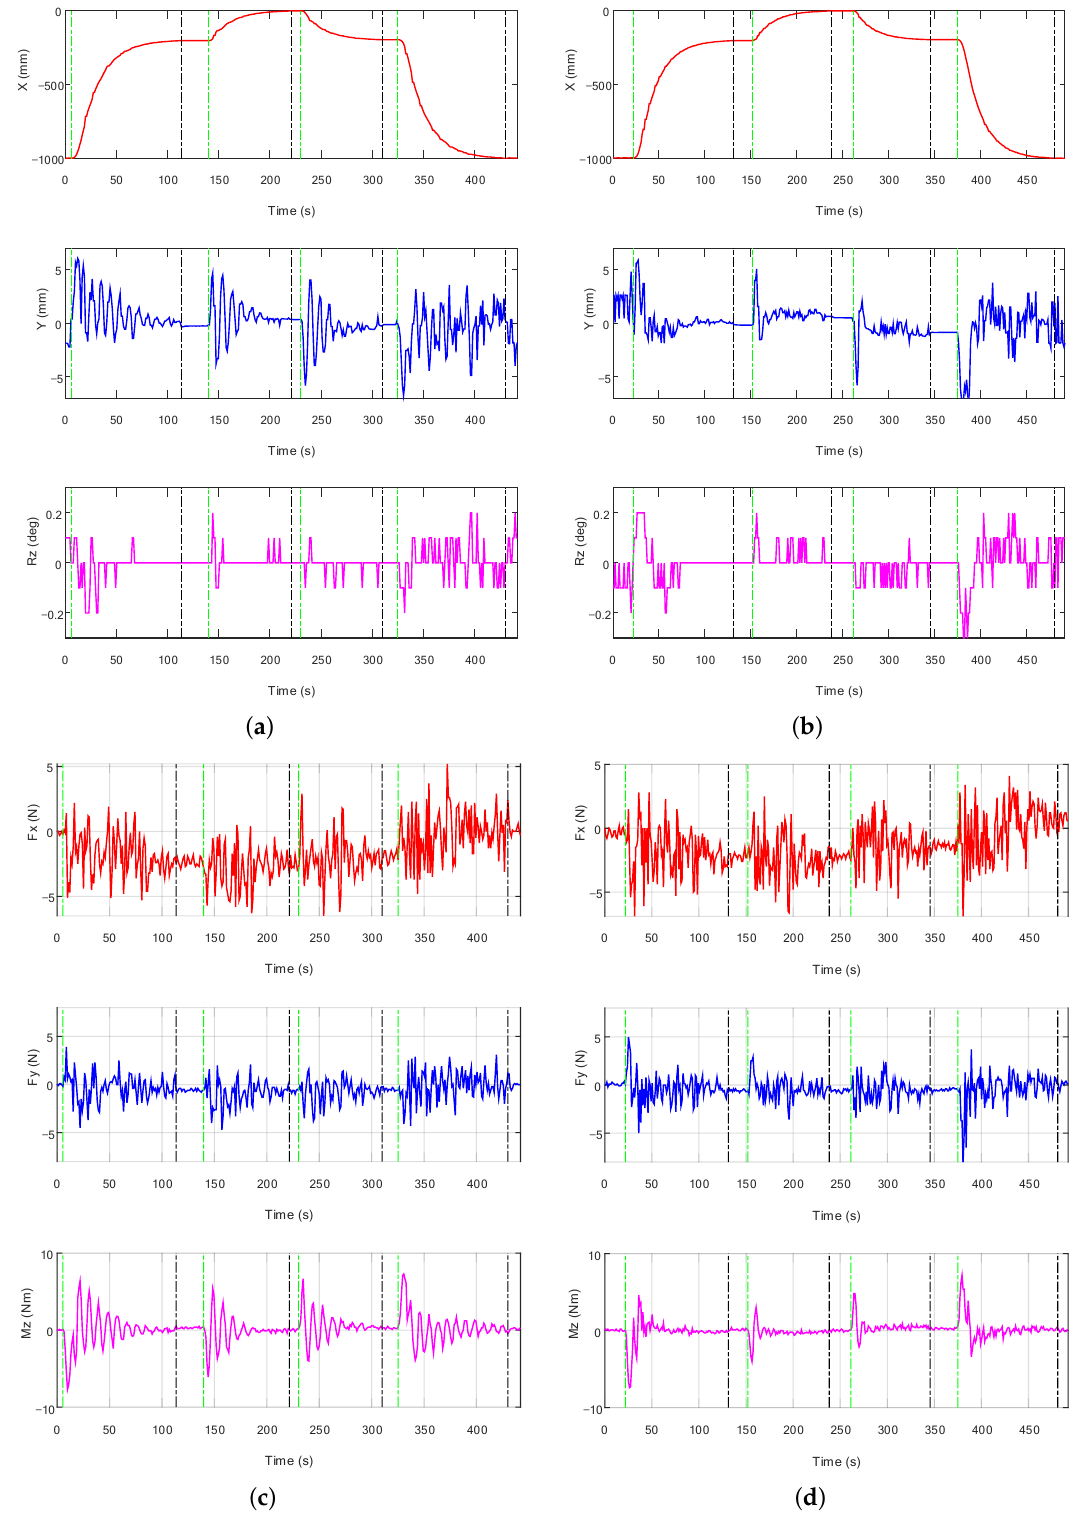
Figure 12. Comparison of the empty load visual servo with or without the base FTS feedback. ( a ) The relative position of the visual servo without FTS feedback, ( b ) the relative position of the visual servo with FTS feedback, ( c ) the reaction torque form base FTS without FTS feedback, ( d ) the reaction torque form base FTS with FTS